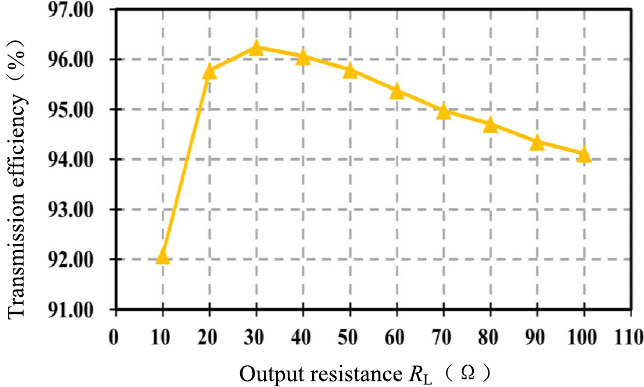
Figure 10. Simulation efficiency without impedance matching.